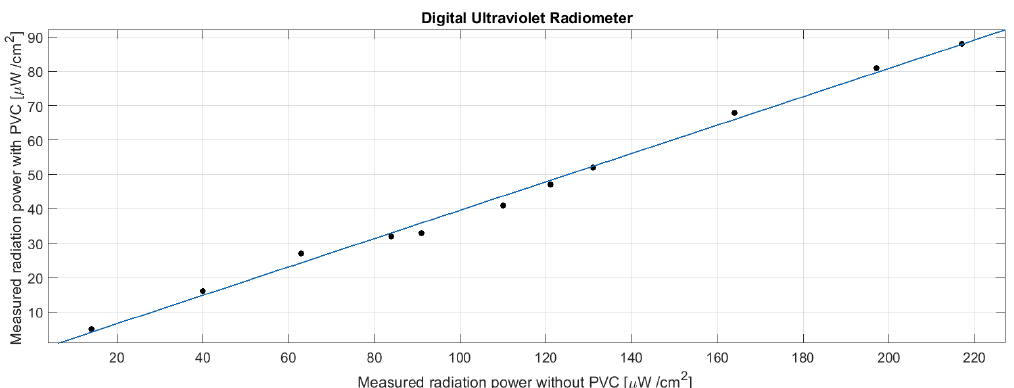
Figure 6. Relationship between the intensity of UVB detected by the digital ultraviolet radiometer outside and inside the PVC case. Each point corresponds to a different time of the day. Linear fit is also